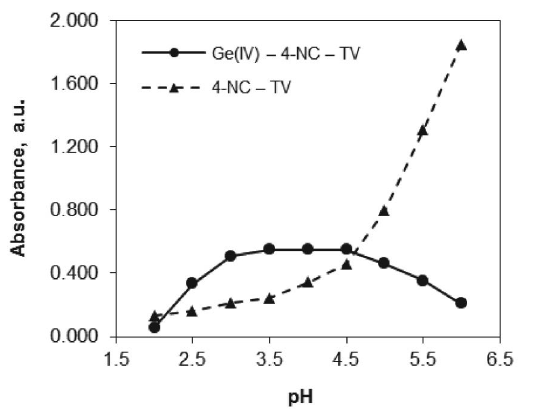
Figure 2. Absorbance of Ge(IV)–4-NC–TV extract against 4-NC- TV extract and of 4-NC–TV against CHCl 3 vs. pH of the aqueous phase; C Ge(IV) = 2.0 × 10 –5 mol L –1 ; C 4-NC = 5.0 × 10 –4 mol L –1 ; C TV = 1.5 × 10 –4 mol L –1 ; λ = 420 nm; τ = 2 min